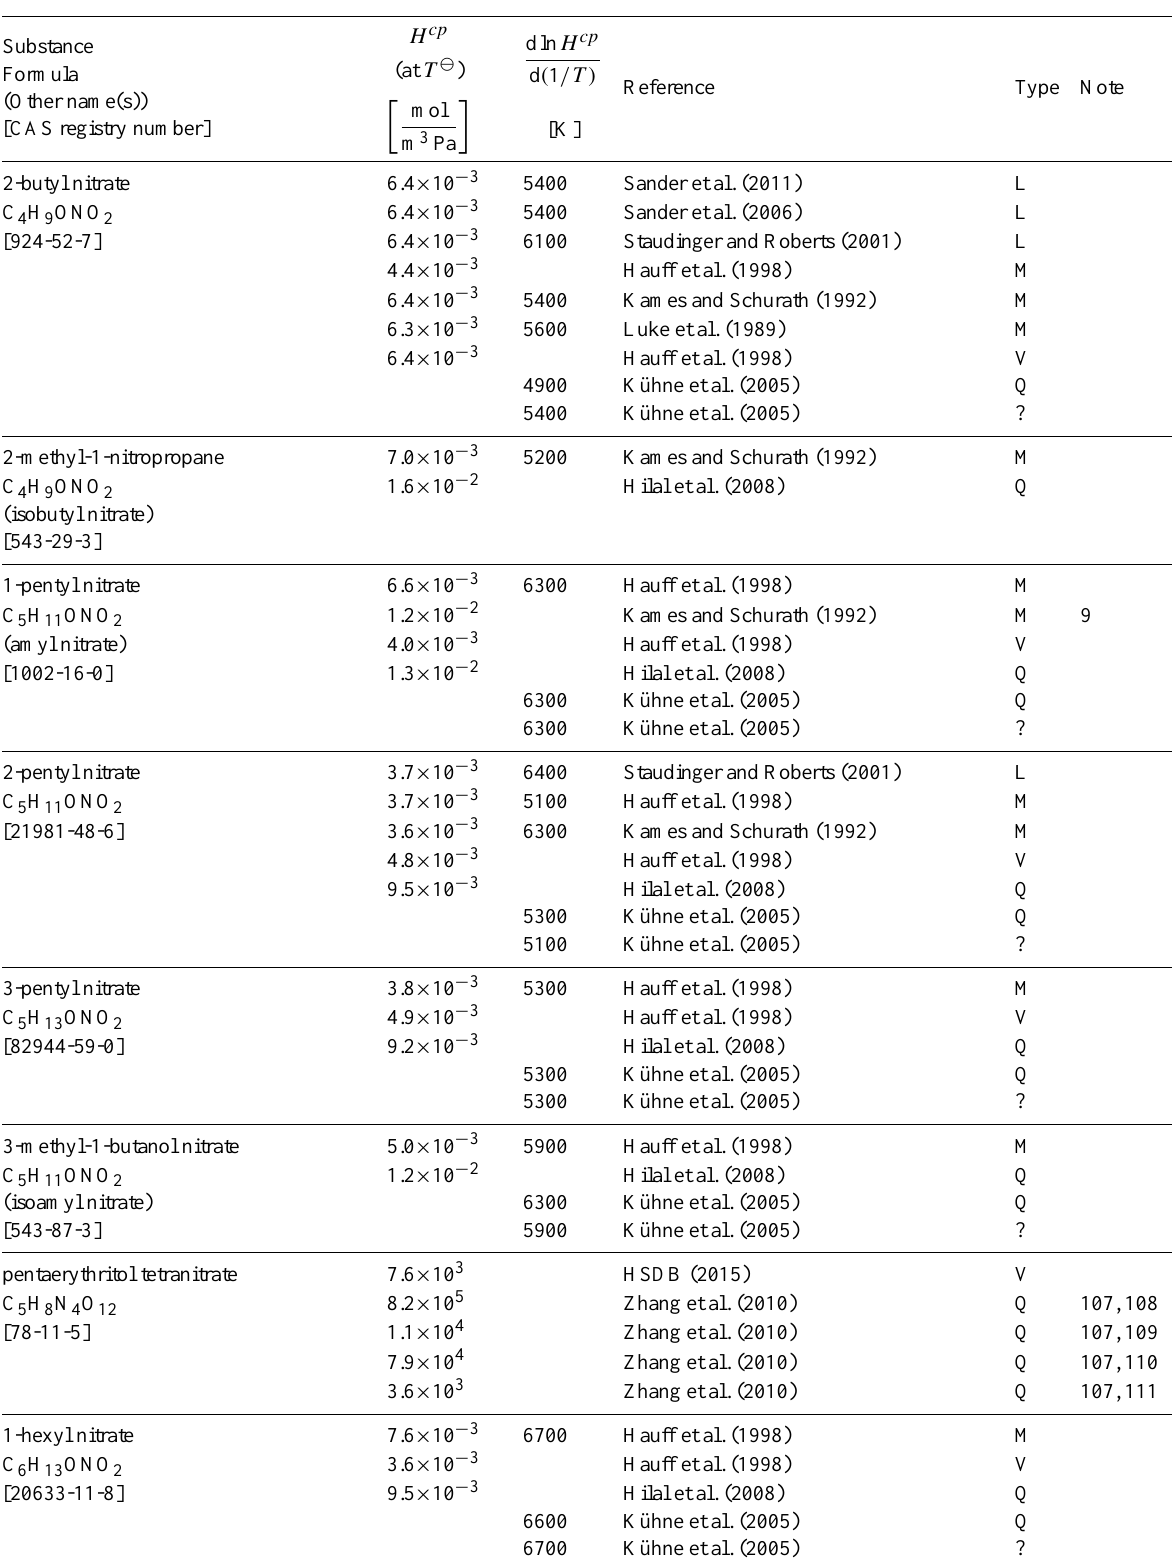
Table 6: Henry’s law constants for water as solvent